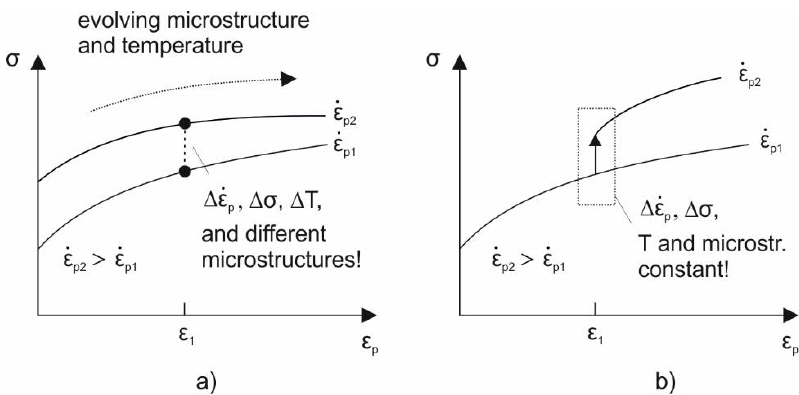
Fig. 1. Schematic illustration of the different approaches used to study the strain rate effects in materials: a) evaluation based on comparing tests carried out at different strain rates involves a comparison between different microstructures and material temperatures, b) sudden change in strain rate (jump) reveals the effects of strain rate on flow stress and strain hardening rate in constant microstructure with small or negligible change in temperature.